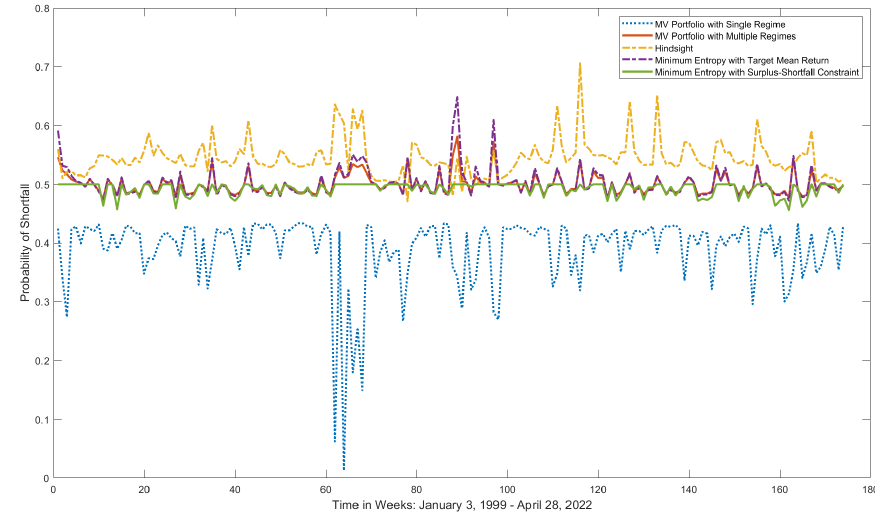
Figure 6. Shortfall probability.